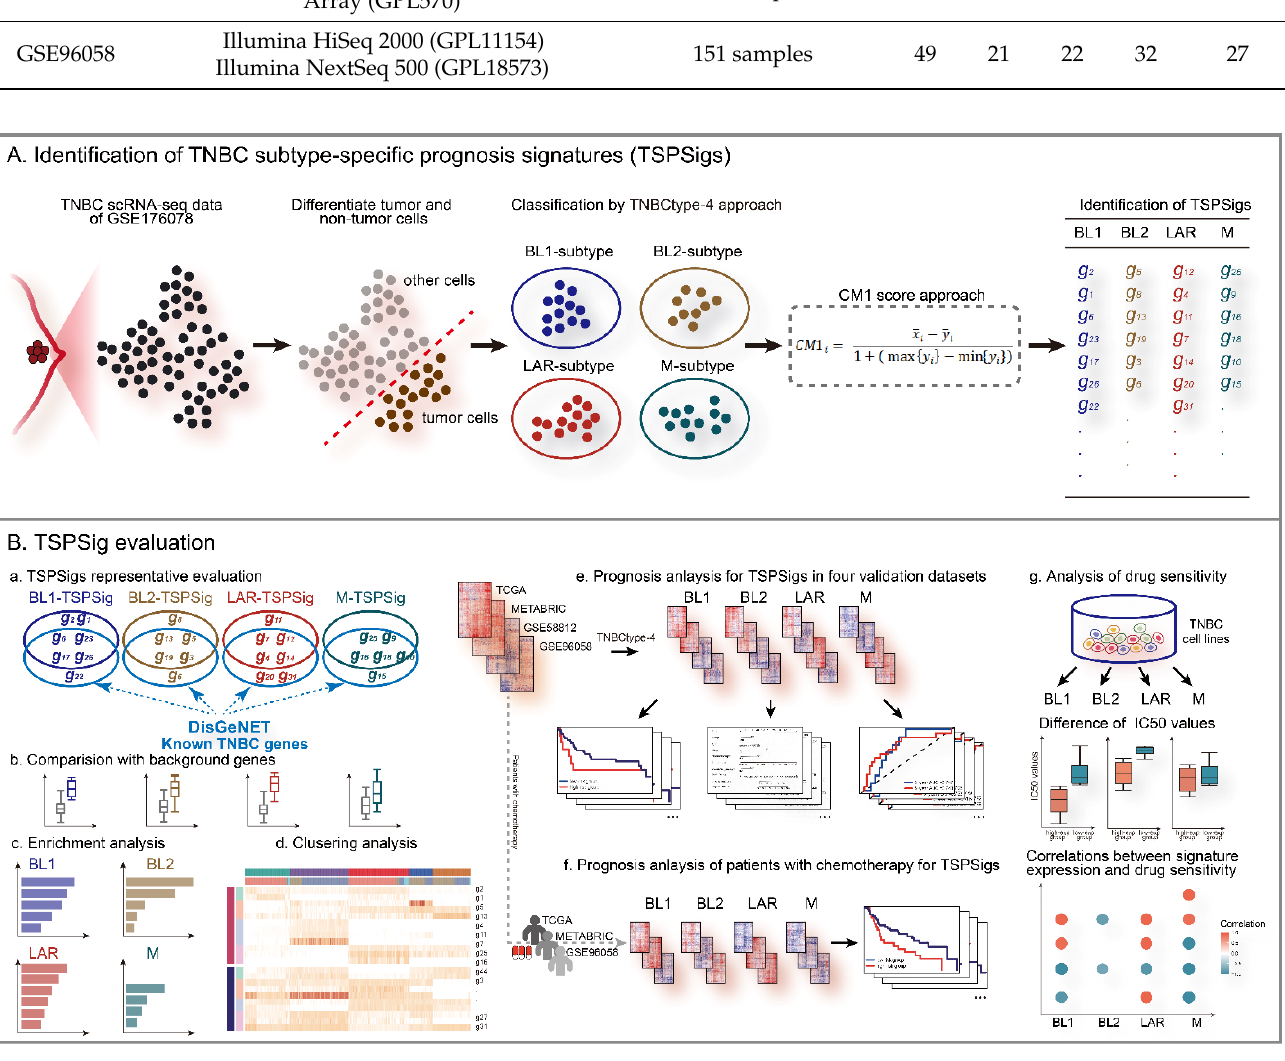
Figure 1. The workflow of this study.